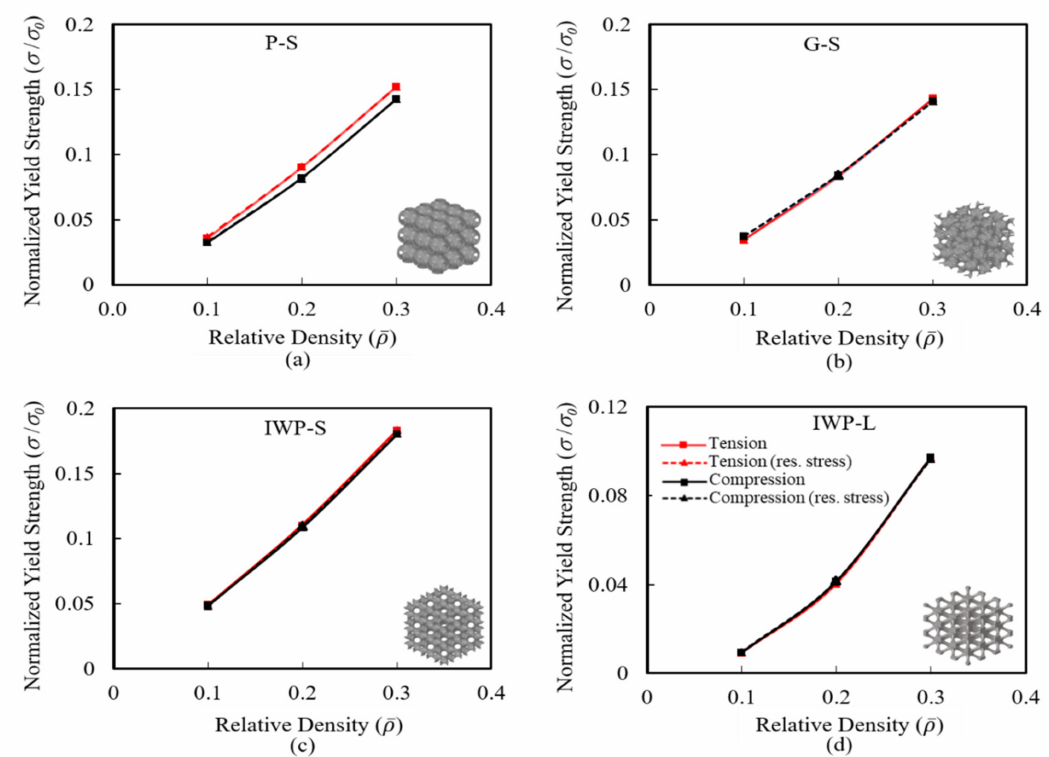
Figure 15. Effect of residual stresses on the normalized yield strength ( σ / σ 0 ) with respect to relative density ρ : ( a ) P-S, ( b ) G-S, ( c ) IWP-S, and ( d )